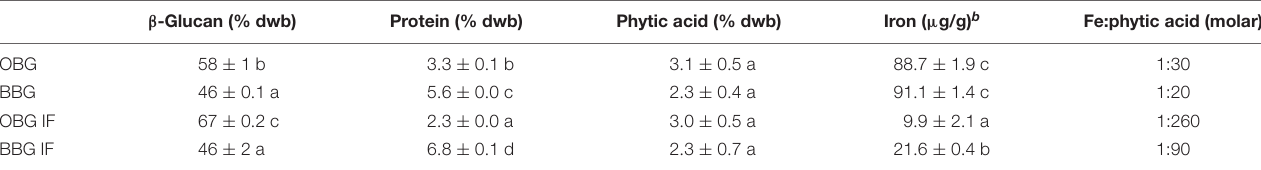
TABLE 1 | Total β -glucan, protein, phytic acid, and iron contents of the native oat (OBG) and barley (BBG) β -glucan extracts, as well as after Chelex-treatment to obtain the “iron-free” (IF) extracts. a β -Glucan (% dwb) Protein (% dwb) Phytic acid (%